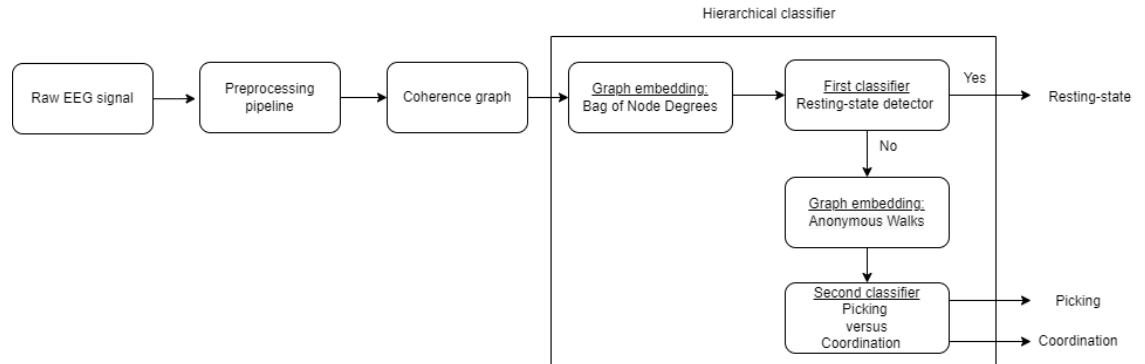
Figure 5. The hierarchical classification process.